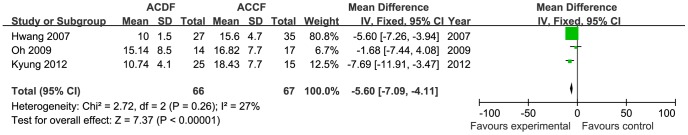
The forest plot for hospital stay between ACDF group and ACCF group, CI  =  confidence interval, df  =  degrees of freedom, IV  =  independent variable,SD  =  standard deviation.